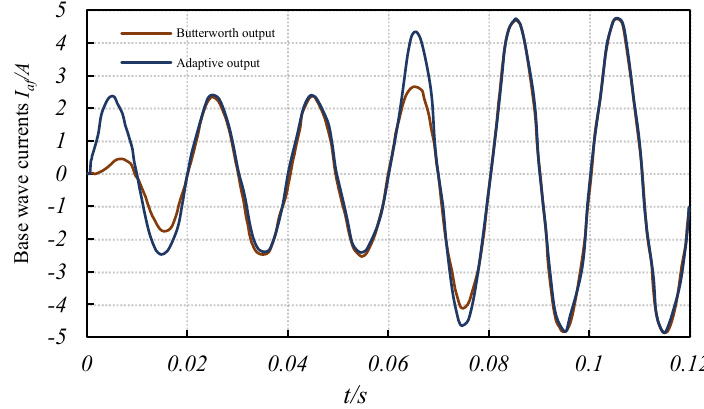
Figure 5. Base wave currents.